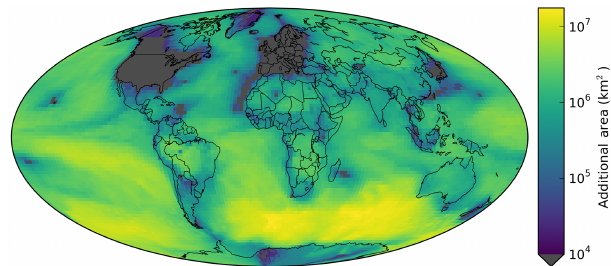
Figure 8. Additional area that a site in each grid box would con- tribute to the global ozone data coverage calculated based on foot- prints from GEOS-Chem.